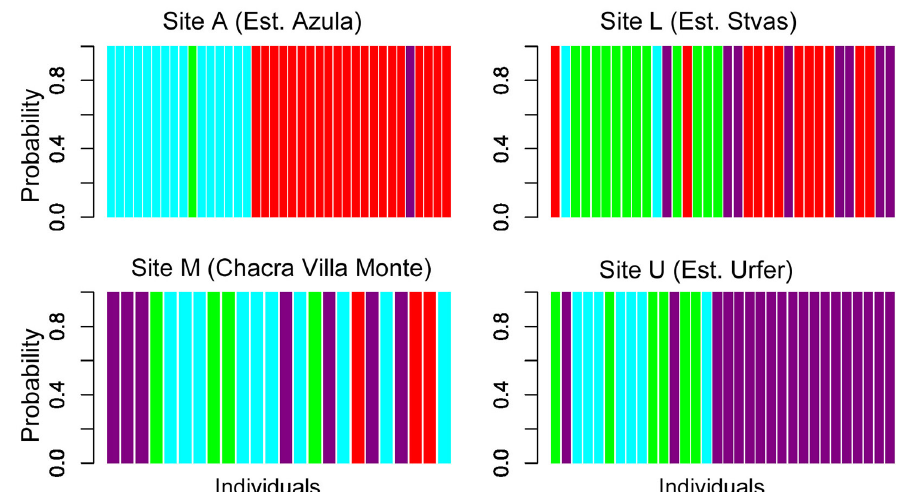
Figure 3. Estimated composition of each “yerba mate” plantation site surveyed based on the individuals´ genetic background. Each individual plant is represented by a thin vertical segment, which can be partitioned into K (K=4) colored segments that represent the individual´s estimated membership probability to the K cluster.